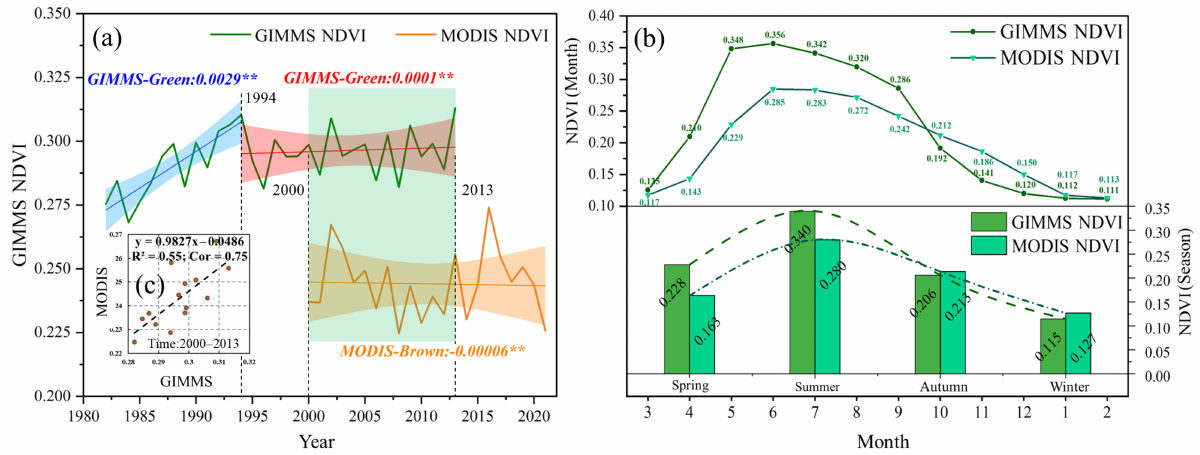
Figure 3. Annual trends in GIMMS NDVI and MODIS NDVI, including their mean values and distribution of monthly (seasonal) NDVI within the year. ( a ) Annual NDVI trends, ( b ) annual and seasonal NDVI variations, ( c ) scatterplot of GIMMS NDVI and MODIS NDVI from 2000 to 2013. Note that ** indicates extreme significance ( p <